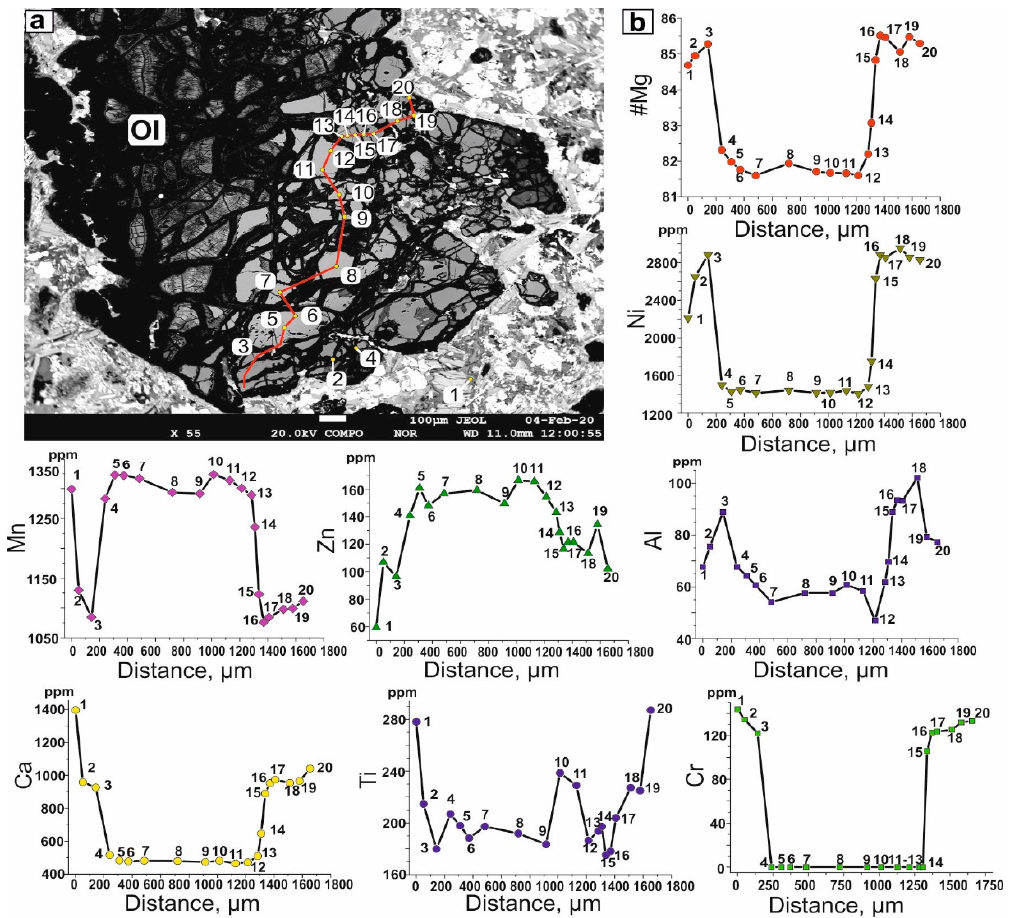
Figure 7. Variation in the trace composition of the olivine-I macrocryst with a relatively low #Mg core, according to WDS analyses (ppm): ( a ) BSE-image with profile line and ( b ) the variation in the components along the profile line.